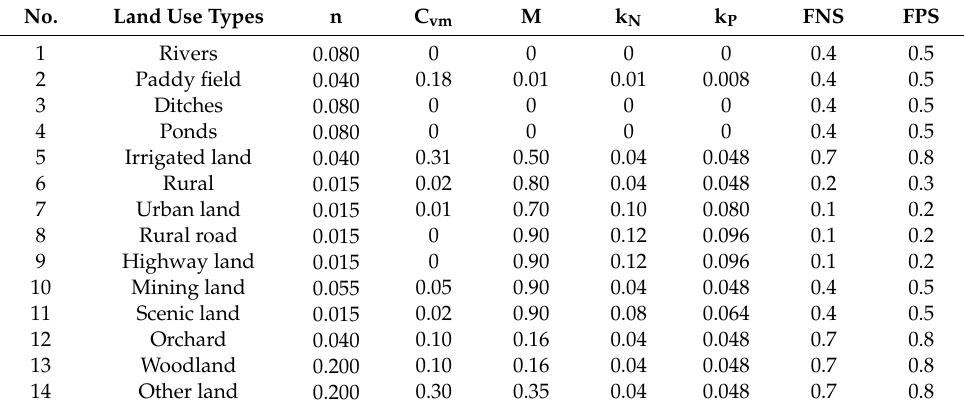
Table 4. Relevant parameters of land use.